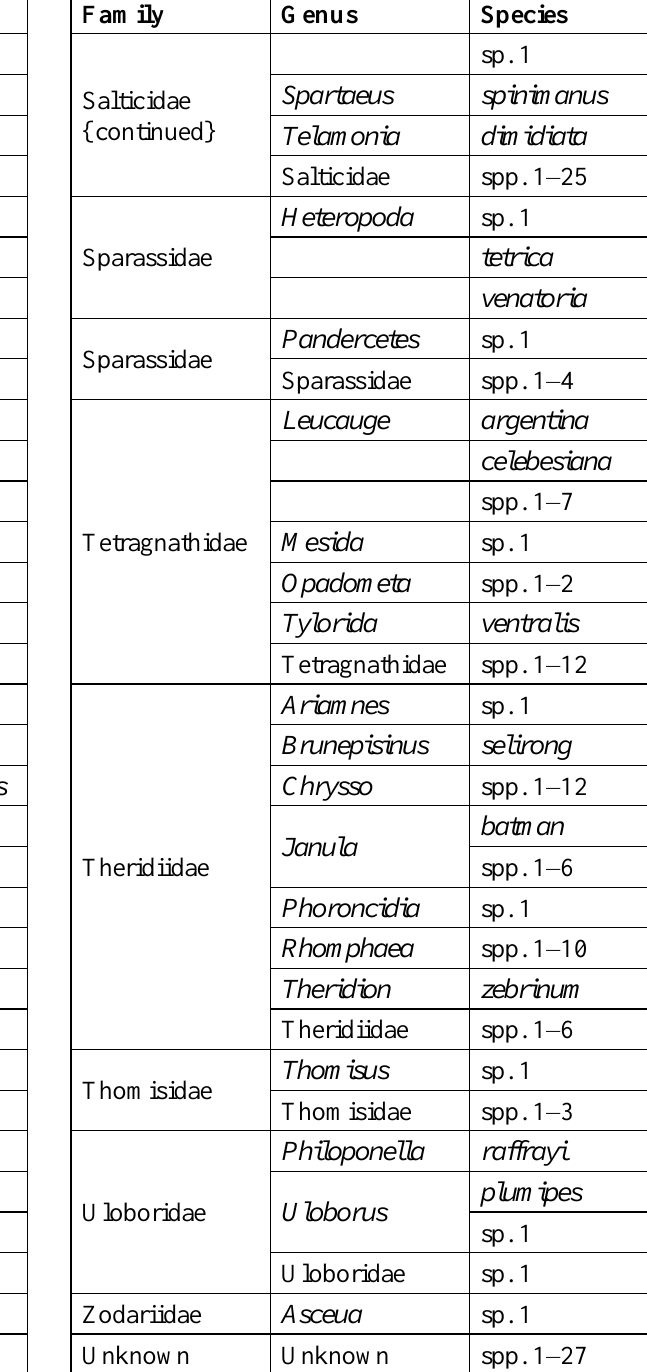
Table A4. List of spider (Araneae) species recorded in the NLPSF, Sebangau. No species identified to species level are listed in the IUCN Red List or Indonesian protected species